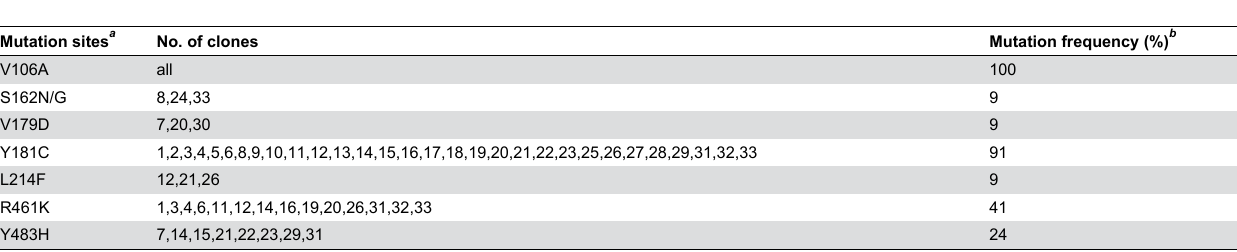
selected by DB-02. IIIB